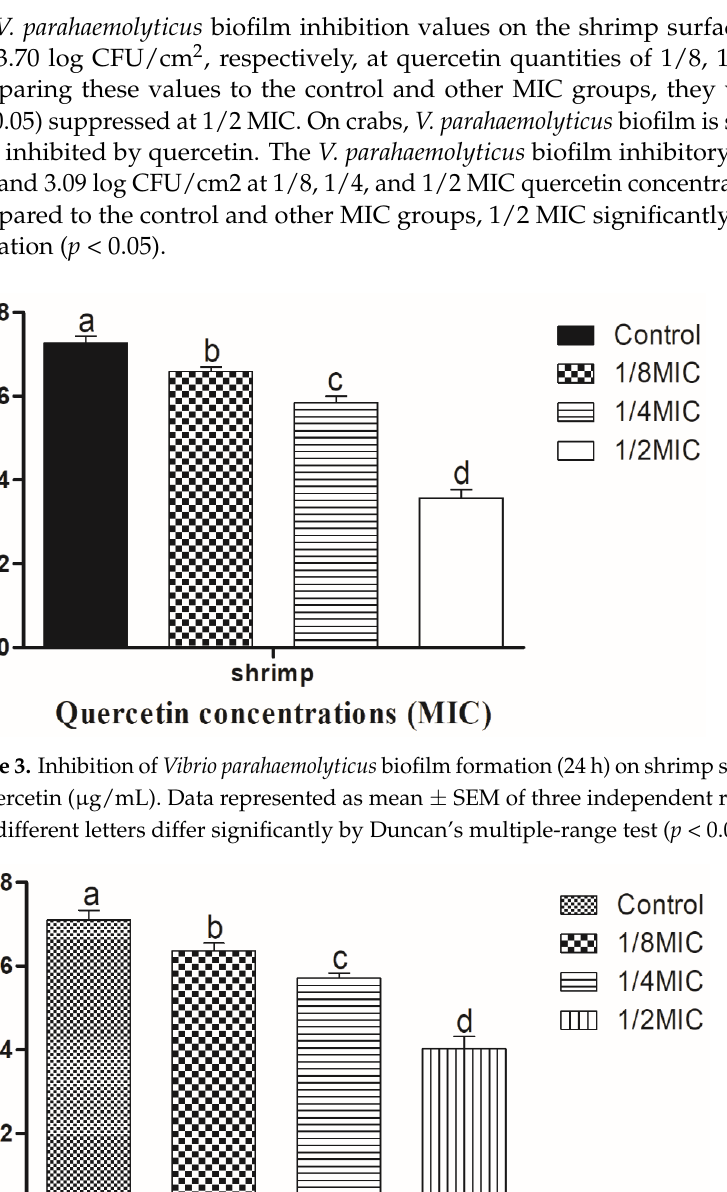
Figure 5. Representative scanning electron micrographs of Vibrio parahaemolyticus biofilms for- mation in the presence of sub-MICs of quercetin on the crab surfaces: ( A ) Control (0% quercetin); ( B ) 1/4 MIC; ( C ) 1/2 MIC and shrimp surfaces; ( D ) Control (0% quercetin); ( E ) 1/4 MIC; ( F ) 1/2 MIC. 3.4. Motility, Biofilm Forming, Virulence, and QS Sensing Relative Gene Expression Pattern Figure 6 shows the expression of V. parahaemolyticus flagella motility ( flaA and flgL ), biofilm formation ( vp0952 and vp0962 ), and QS ( luxS and aphA ) determined by RT-PCR in the sub-MIC of quercetin (from 0 to 110 µg/mL). At the various sub-MIC concentrations of quercetin, gene expressio was considerably downregulated ( p < 0.05). This section may